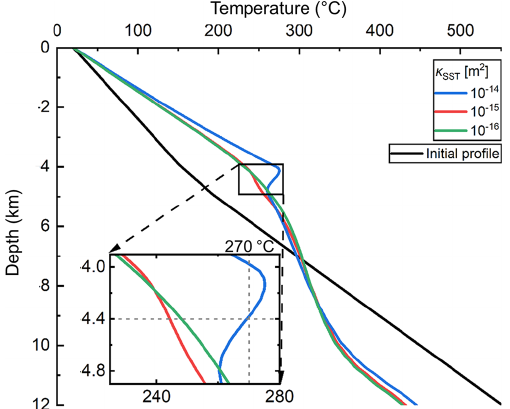
Figure 10. Effects of the sandstone permeability ( κ SST ) on the temperature-depth profiles. The κ SST = 10 − 15 m 2 case represents the reference case.